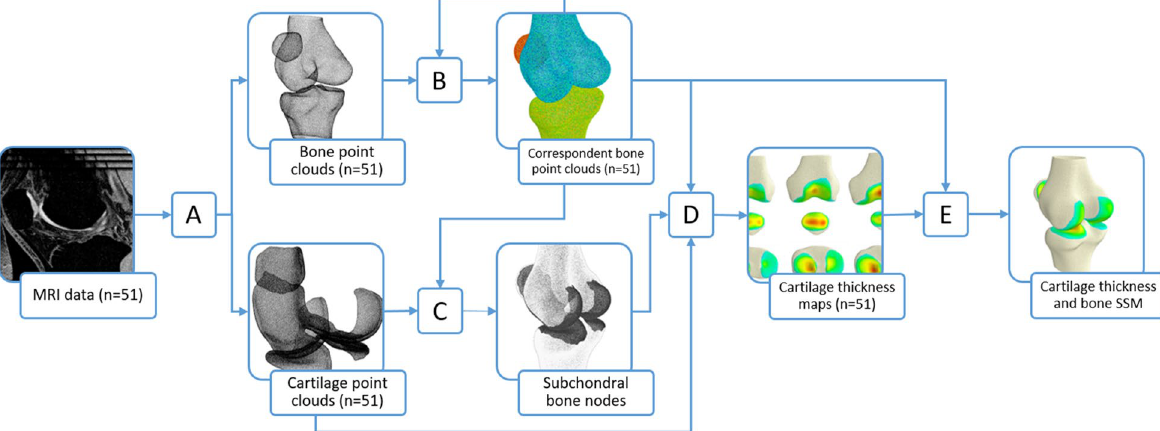
Figure 1. Schematic of workflow to generate cartilage thickness field and bone shape model. MR images (n = 51) of the knee were segmented, processed in MAPClient, and resampled ( A ) to produce bone and cartilage point clouds. Parametric or correspondent bone point clouds were obtained via an iterative fitting process ( B ). Subchondral bone node numbers on these correspondent point clouds were found by combining node numbers obtained from all subjects using a closest-point algorithm ( C ). Cartilage thickness maps were calculated ( D ) by computing the magnitude of the projection of the closest articular cartilage point to the normal vector of each subchondral bone node. Principal component analysis ( E ) was performed on features consisting of the corresponding nodal coordinates of the bone and the cartilage thickness per subchondral node to produce a statistical model of the cartilage thickness and bone